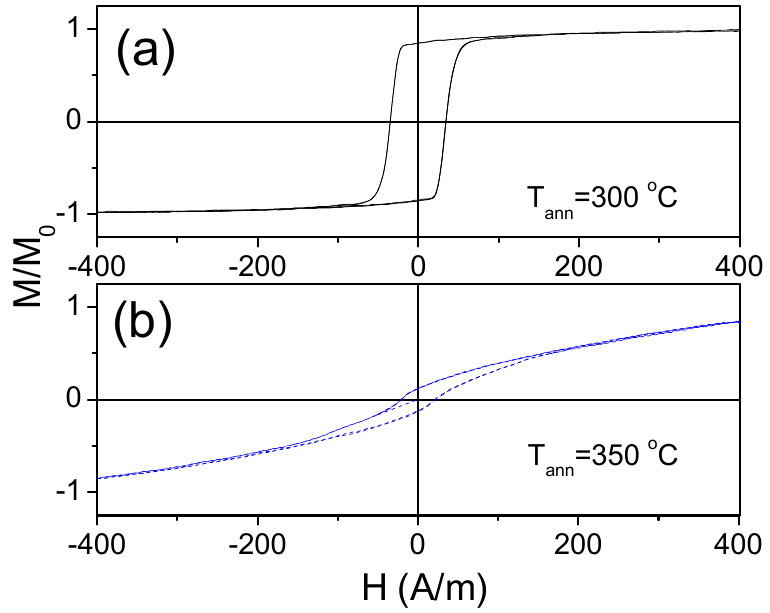
Figure 2. Hysteresis loops of as-prepared ( a ); stress-annealed at T ann = 300 °C for σ a = 450 MPa ( b ), and for σ a = 900 MPa ( c ) Fe 75 B 9 Si 12 C 4 microwires.